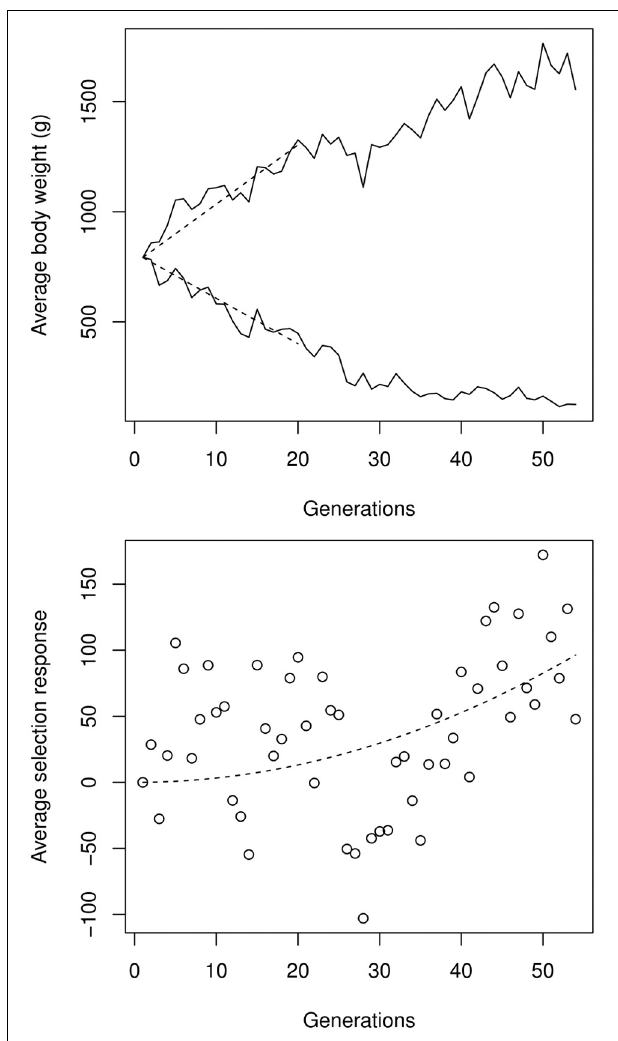
FIGURE 4 | Top: male-female average experimental selection response on chicken bodyweight, digitalized from Figures 1, 2 in Dunnington et al. , estimated by a linear regression (2013). The initial selection response (cid:4) μ 0 over the first 20 generations (dashed segments), was 25.6g per generation in the high line, and − 19.6g per generation in the low line. Bottom: quadratic regression on the up- and down-selection average, illustrating the cumulative effect of directional epistasis. The quadratic coefficient (which is ε ), estimated by a non-linear, least-square an approximation of (cid:4) 2 μ 0 regression, was 0.033g per generation